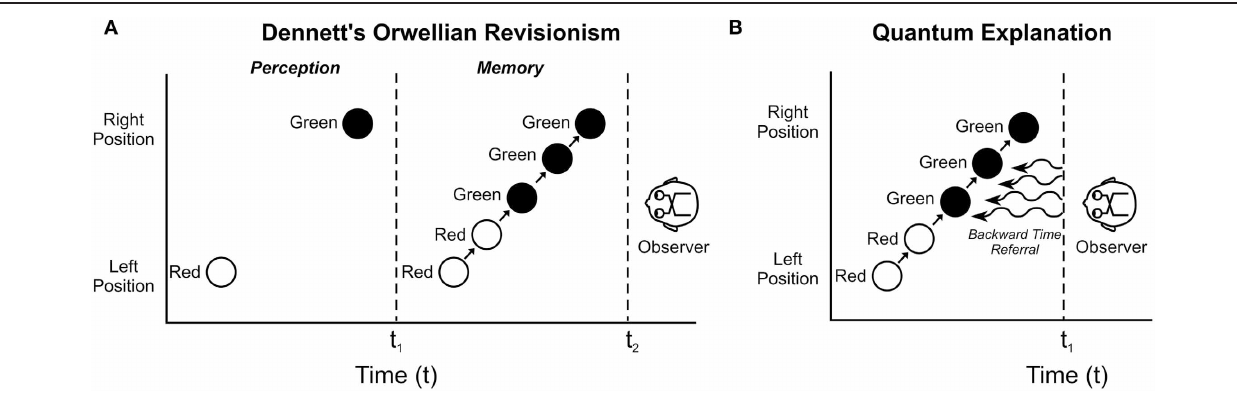
“Orwellian Revisionism,” the brain constructs, or fills in the movement and transition after the fact, and inserts a constructed perception into memory. Real-time perception is not conscious. (B) In a “Quantum Explanation,” temporal non-locality and backward time referral allow real-time, veridical conscious